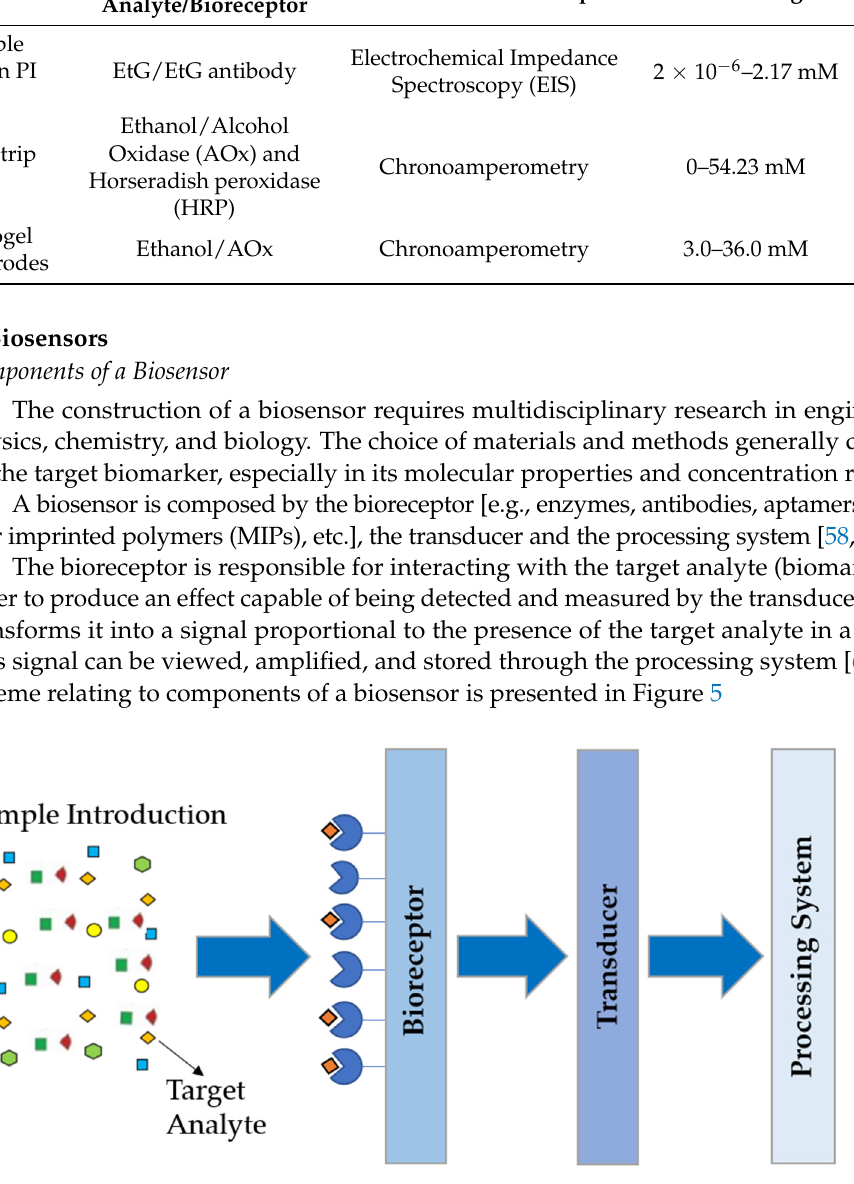
Figure 5. Schematic of the main components and mechanism of a biosensor [63].